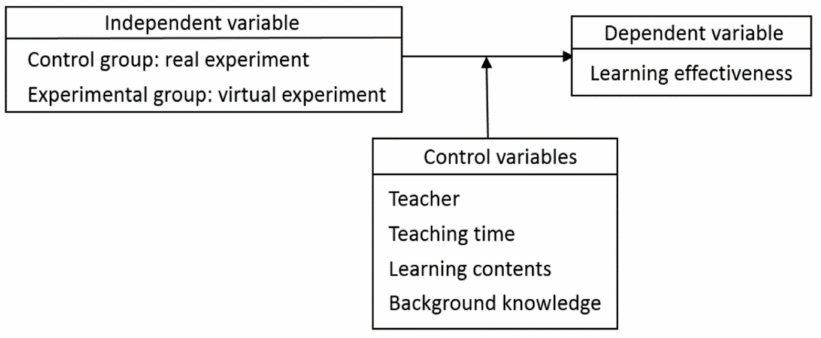
Figure 13. The research structure and its variables.